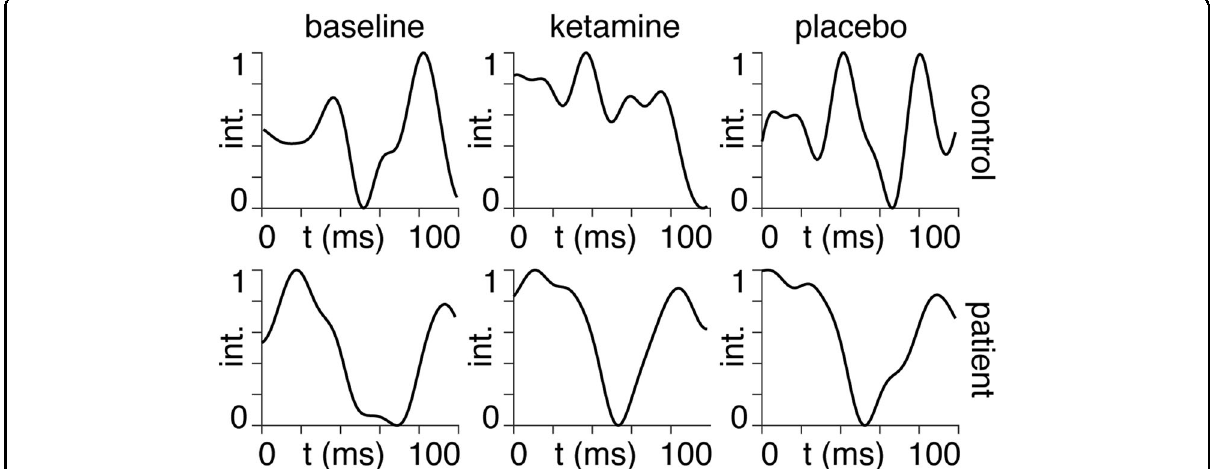
Fig. 1 ERPs. Averaged ERP timecourses for the fi rst 100 ms following airpuff stimulation ( fi rst-time point). The y -axis shows the MEG signal intensity (int.), normalised between zero and unity. The three conditions: baseline, ketamine and placebo are shown from left to right for a healthy control subject (top row) and a single TRD patient (bottom